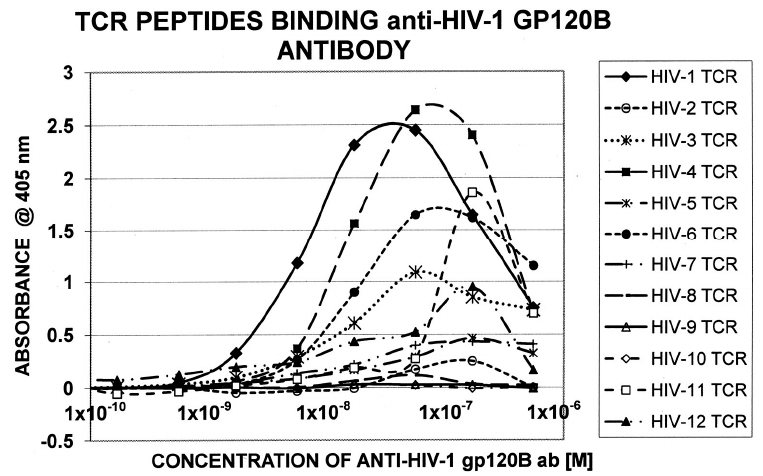
Figure 5. Quantitative ELISA experiments between goat anti-HIV-1 gp120B antibody and the TCR sequences listed in Figure 2.